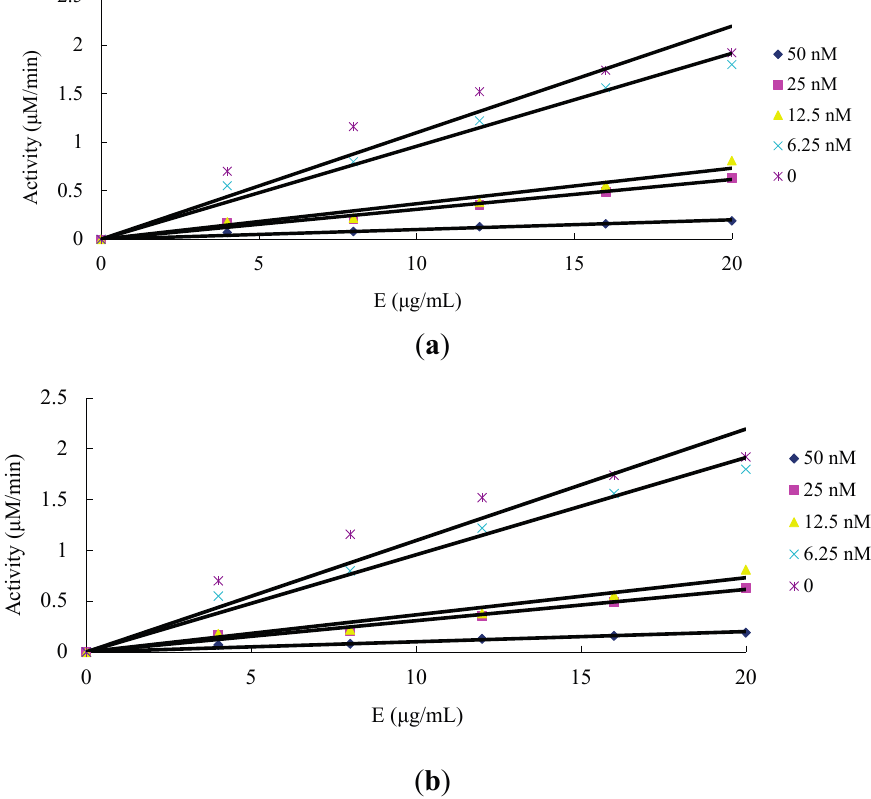
Figure 2. The effect of mitochondrial complex I concentration on catalysis activity of β -Nicotinamide adenine dinucleotide, reduced disodium salt hydrate (NADH) at different concentrations of amorphigenin ( a ) and rotenone ( b